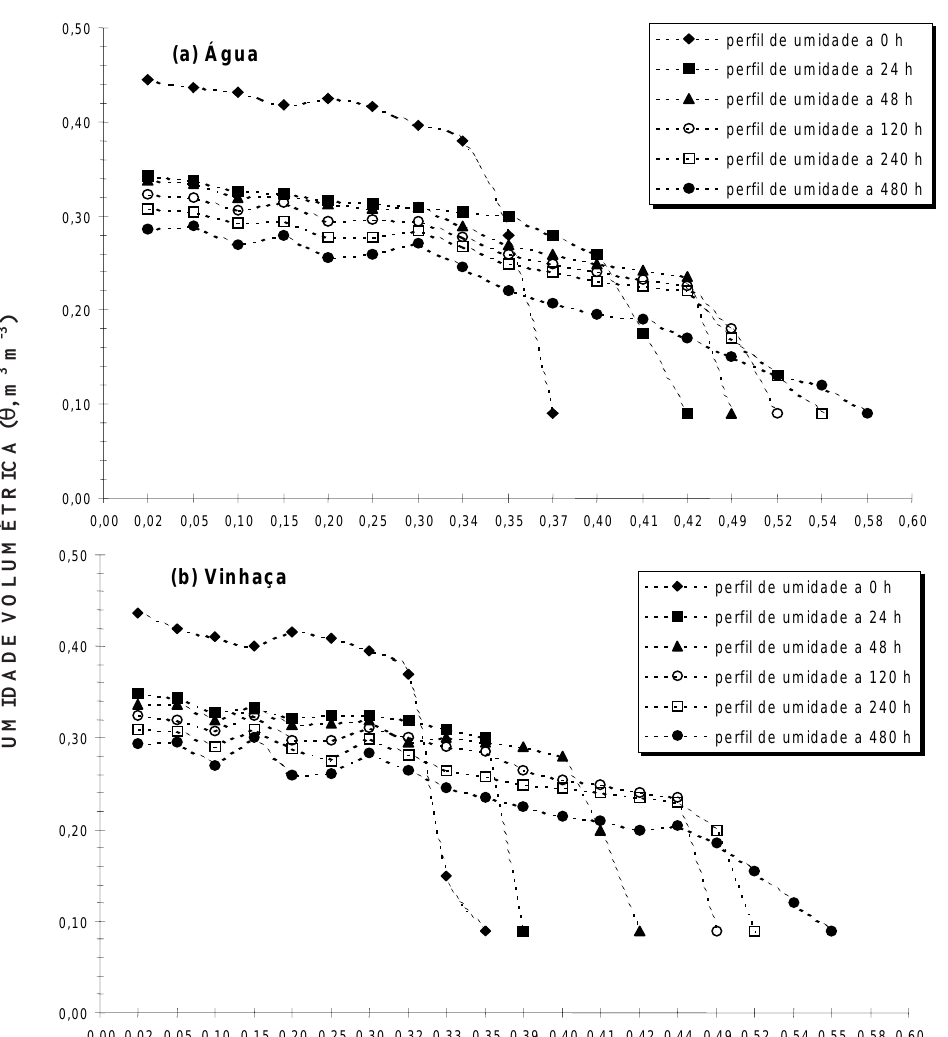
Figura 3. Perfis de umidade durante o processo de redistribuição em coluna de solo tratado com água (a) ou vinhaça (b), na dosagem de 1.000 m 3 ha -1